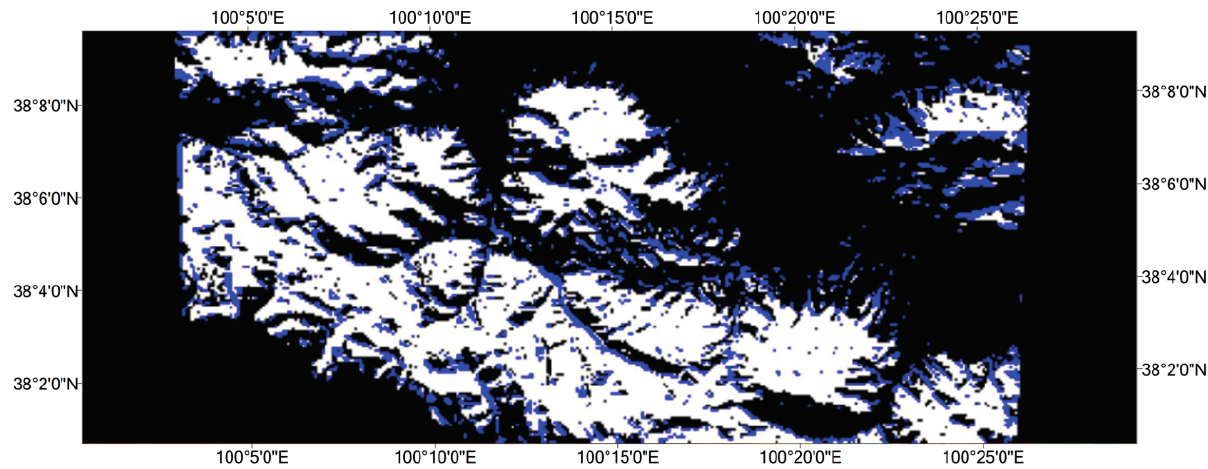
Figure 10. Differences between the high-resolution downscaled and remotely sensed snow maps for 17 March 2008. Snow-free areas and areas lacking data are shown in black in both maps; snow-covered areas in the remotely sensed map that were identified as being snow-free in the downscaled map are blue; and snow-covered regions in both maps are